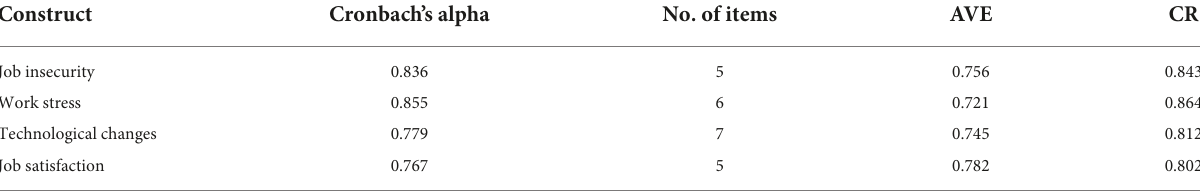
TABLE 4 Construct reliability and convergent validity through AVE.